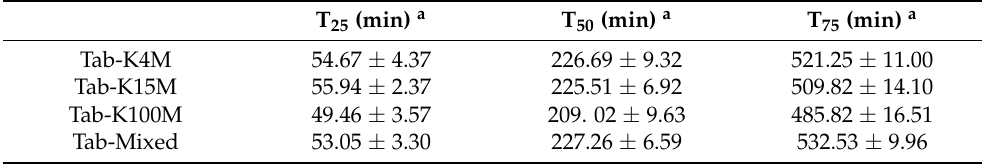
Table 4. T 25 , T 50 , and T 75 for the release of PNL from compressed HPMC-based matrix